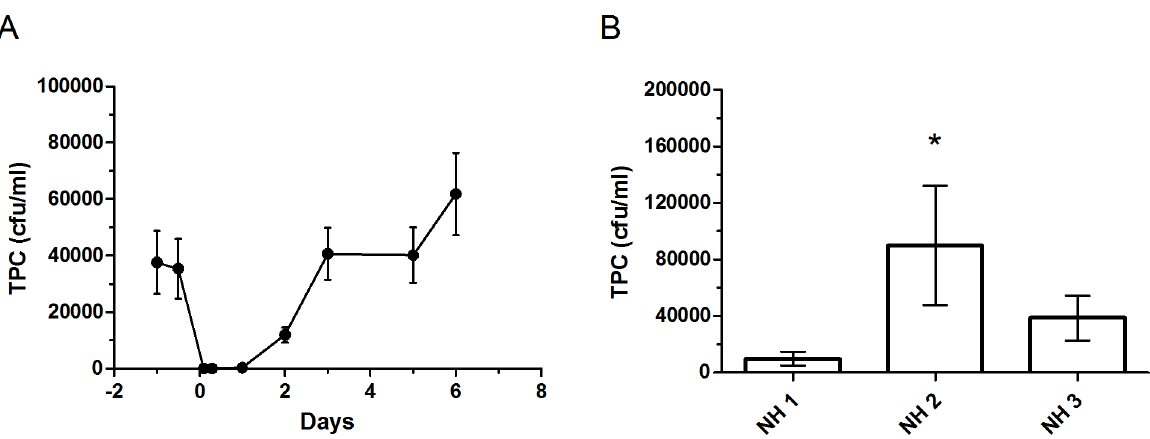
Fig. 4. Effect of hot water-treatment on TPC. A) TPC as a function of time before, just after (0), and days after hot water treatment of shower systems (4 different shower system, 6–9 showers per system). The data is presented as an average of all treated shower systems and the error bars represent the standard deviation. B) Comparison of TPC at the three nursing homes NH 1, NH 2 and NH 3. The included showers (N 5 8) at NH 1 had not been hot water- treated, while the ones at NH 2 (N 5 16) and 3 (N 5 14) had been at least monthly treated for years. The TPC was measured one week after thermal treatment. Additionally, at NH 3 the shower armature were systematically treated with a product aimed at eliminating lime depositing. * The difference between NH 1 and NH 2 was significant (P , 0.05, non-parametrical).